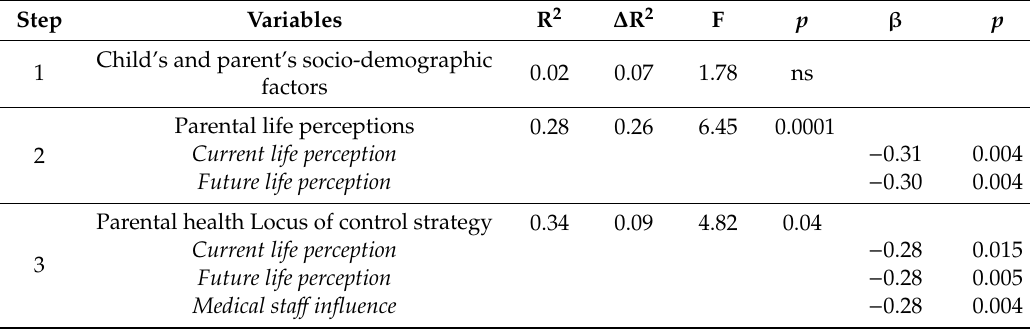
Table 5. Hierarchical regression predicting Parental depressive